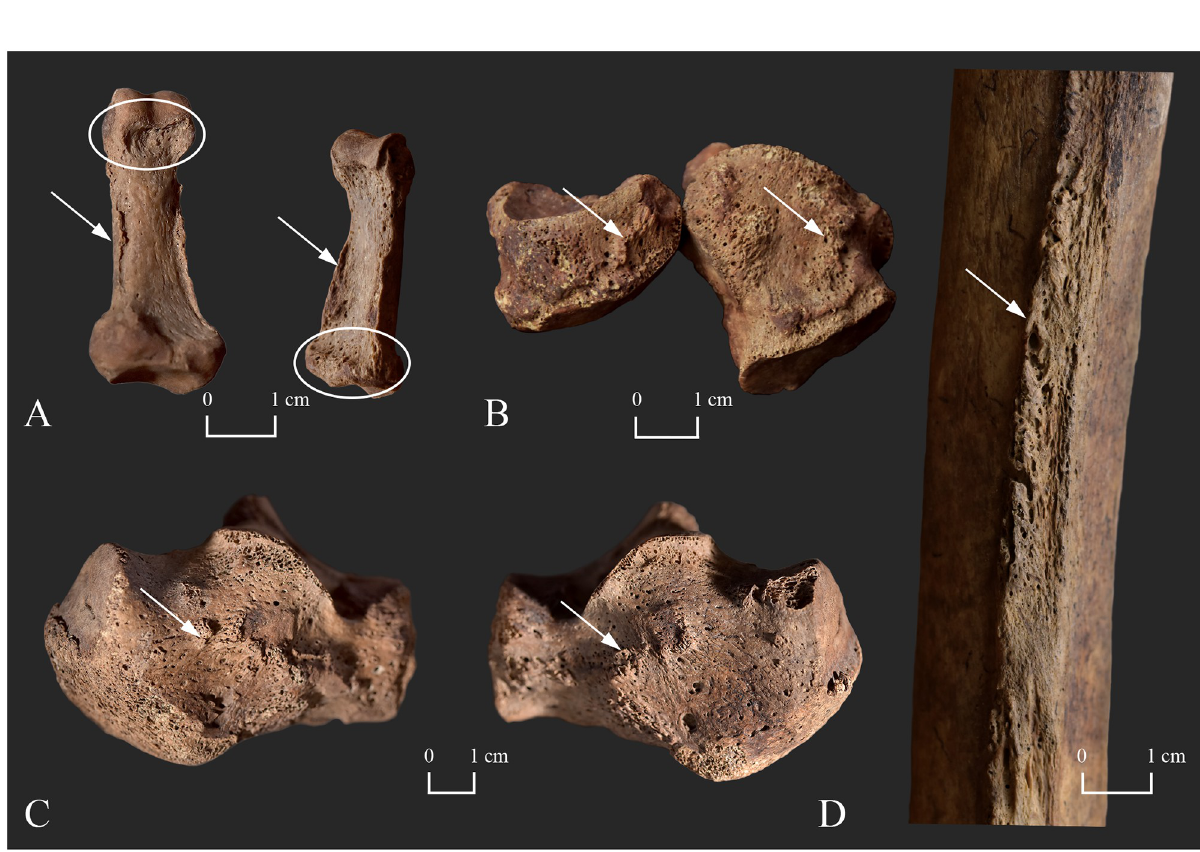
Fig 6. Bony changes indicative of leprosy in the postcranial skeleton of KD271. A) Shallow grooving in the juxta-articular area of the distal end of the right 5 th proximal phalanx (palmar surface–white ellipse), bevelling at the base of the right 4 th middle phalanx (palmar surface–white ellipse), and marginal osteophytes on both sides of the diaphysis of the right 5 th proximal and right 4 th middle phalanges (palmar surface–white arrows); B) Exostoses on the dorsal surface of the left navicular and cuboid bones (white arrows); C) Exostoses on the lateral surface of the right and left calcanei (white arrows); and D) Exostoses on the posterior surface of the right femur (along the linea aspera –white arrow).